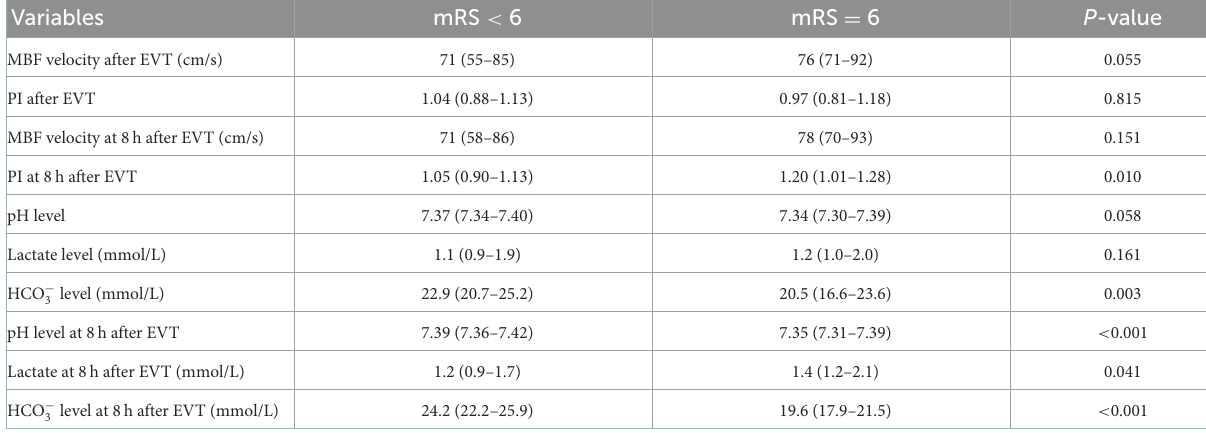
TABLE 5 Comparison between favorable and poor prognosis according to the outcome: